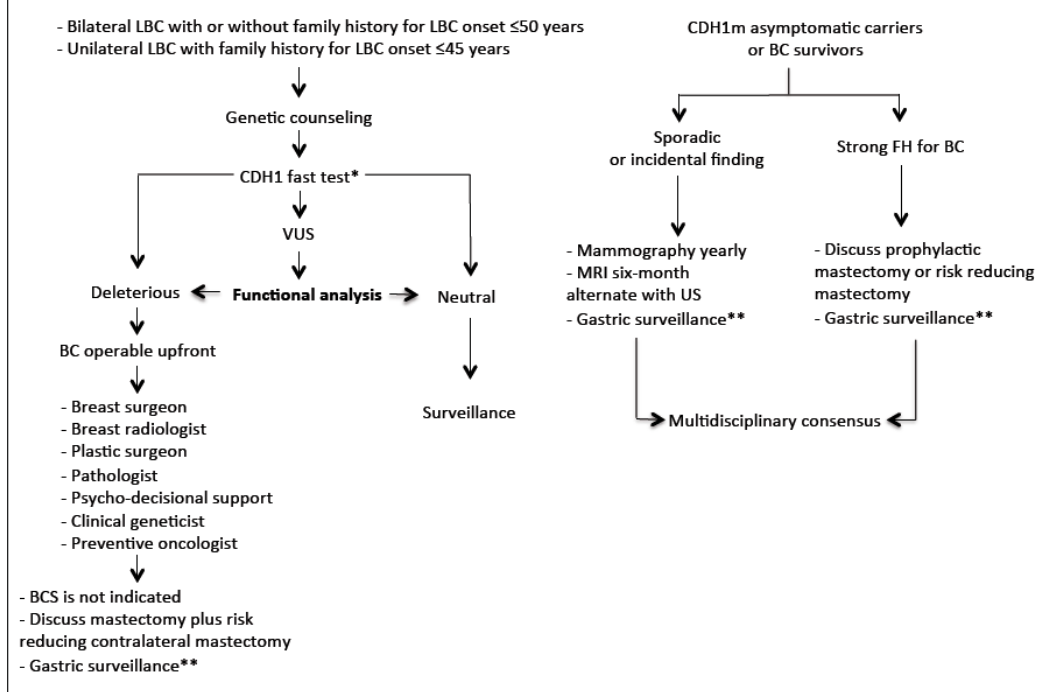
Figure 3. The flow-chart describes the clinical management of hereditary lobular breast cancer predisposition (* In case of CDH1 neg test BRCA1/2; ** Cambridge protocol).